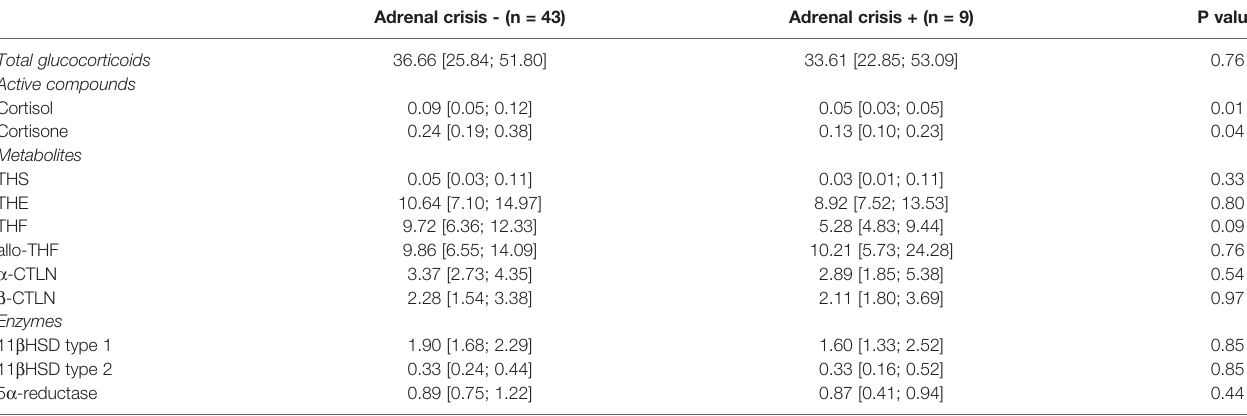
TABLE 4 | Urinary steroids and metabolites in patients with and without adrenal crisis on the lower dose hydrocortisone (0.2-0.3 mg/kg/day).